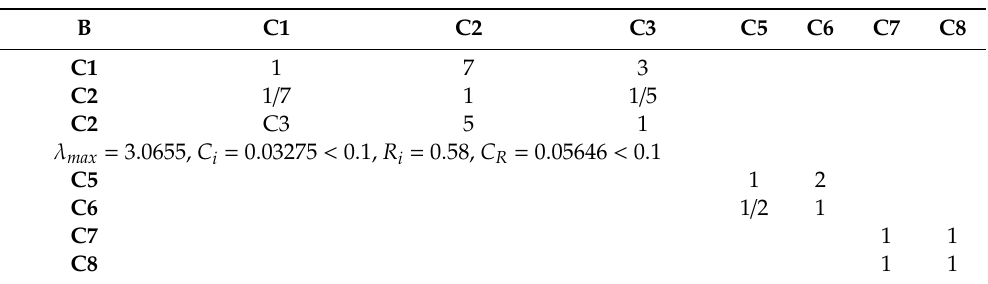
Table 5. Judgment matrix of indicator layer (layer C).